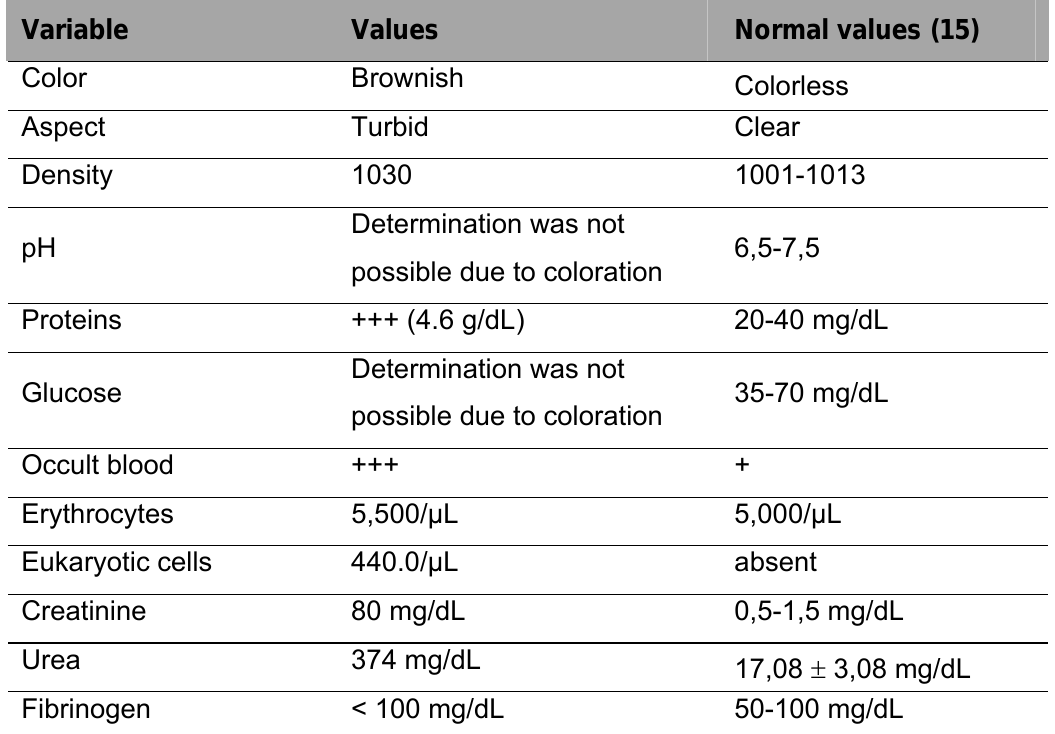
Table 3. Peritoneal effusion of a young ovine previously hyperimmunized with Crotalus durissus terrificus venom, 12 hours after hospitalization Variable Values Normal values (15) Color Brownish Colorless Aspect Turbid Clear Density 1030 1001-1013 Determination was not pH 6,5-7,5 possible due to coloration Proteins +++ (4.6 g/dL) 20-40 mg/dL Determination was not Glucose 35-70 mg/dL possible due to coloration Occult blood +++ + Erythrocytes 5,500/ μ L 5,000/ μ L Eukaryotic cells 440.0/ μ L absent Creatinine 80 mg/dL 0,5-1,5 mg/dL Urea 374 mg/dL 17,08 ± 3,08 mg/dL Fibrinogen < 100 mg/dL 50-100 mg/dL Note: clotting, reactive lymphocytes and erythrophagocytosis were positive. Cytology: whole erythrocytes; predominance of segmented neutrophils (31%), followed by lymphocytes (30%), macrophages (23%), mesothelial cells (10%) and erythroblasts